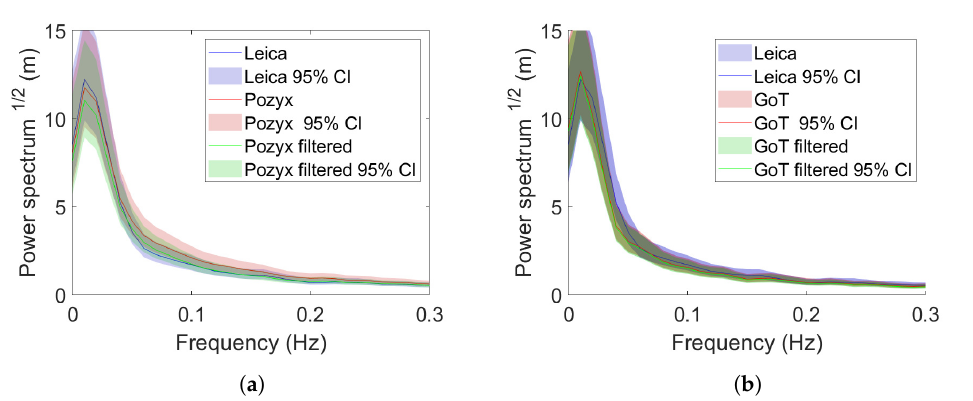
Figure 18. Y-direction traces in the frequency domain after pre-filtering with and without Wiener filtering. ( a ) Leica/Pozyx. ( b )